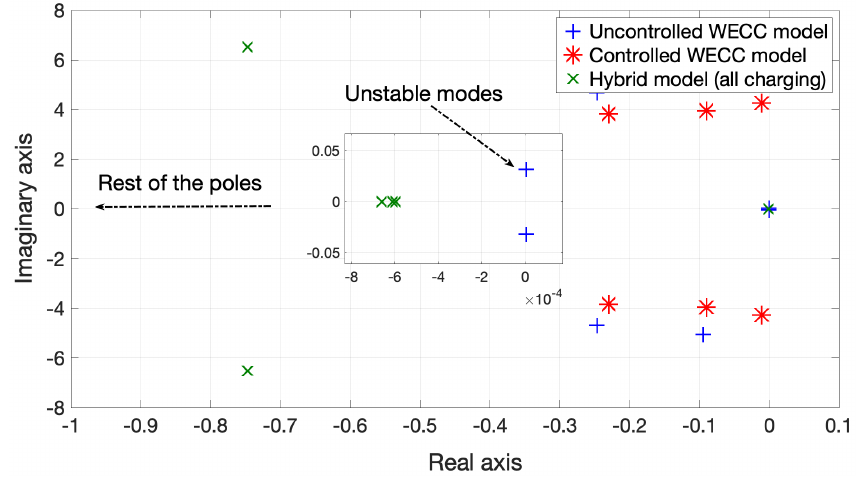
Figure 8. The eigenvalues of the case study model with WECC model for battery